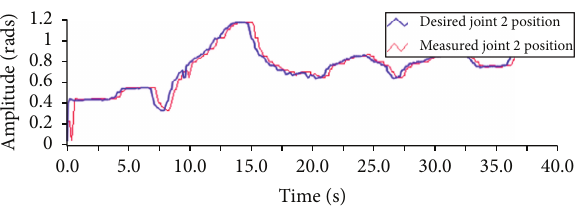
Figure 16: Desired and measured joint 2 position.